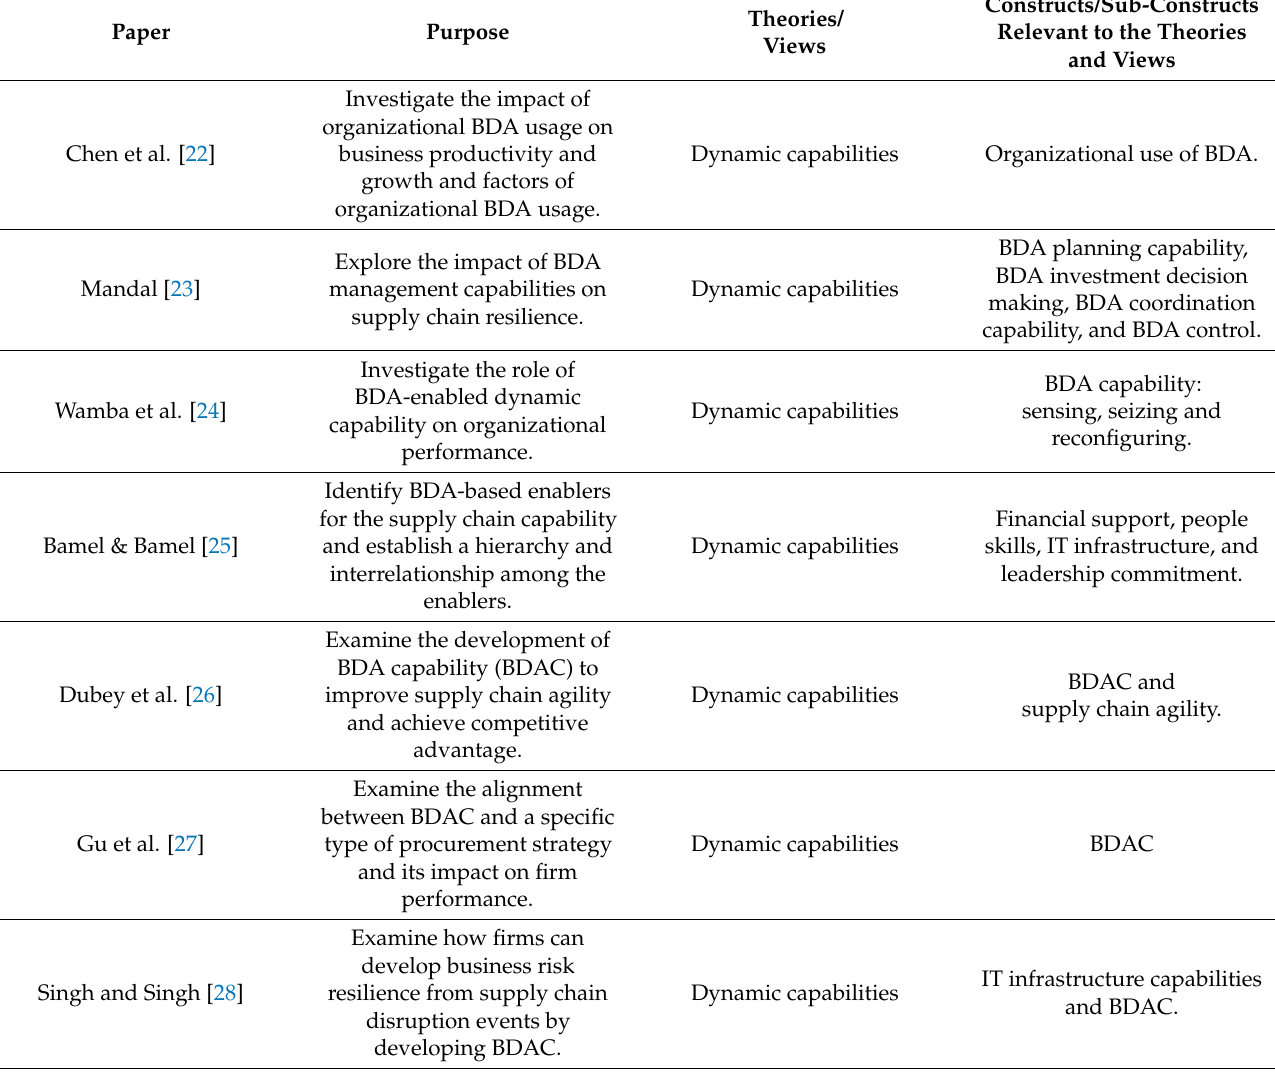
Table 4. Paper, purpose, theories/views, and constructs/sub-constructs of organizational